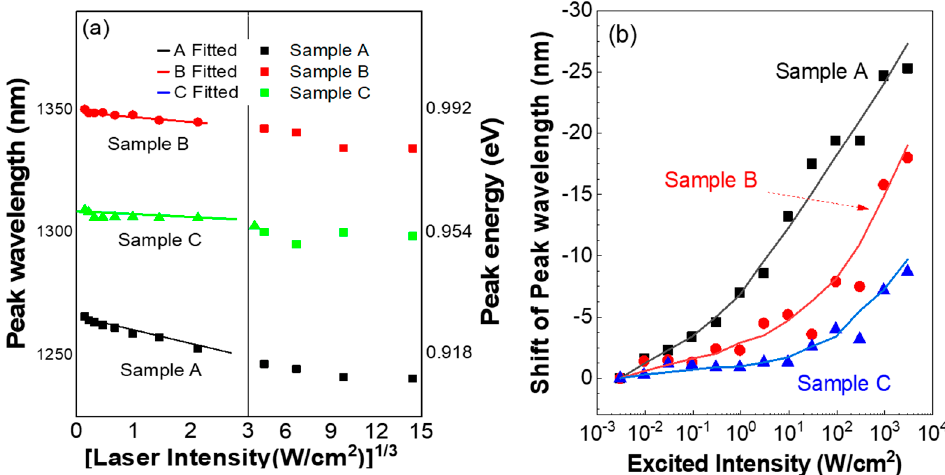
Figure 5. ( a ) The PL peak wavelength (energy) as a function of the cube root of the laser excitation intensity. ( b ) The Shift of PL peak wavelength as a function of the laser excitation intensity.